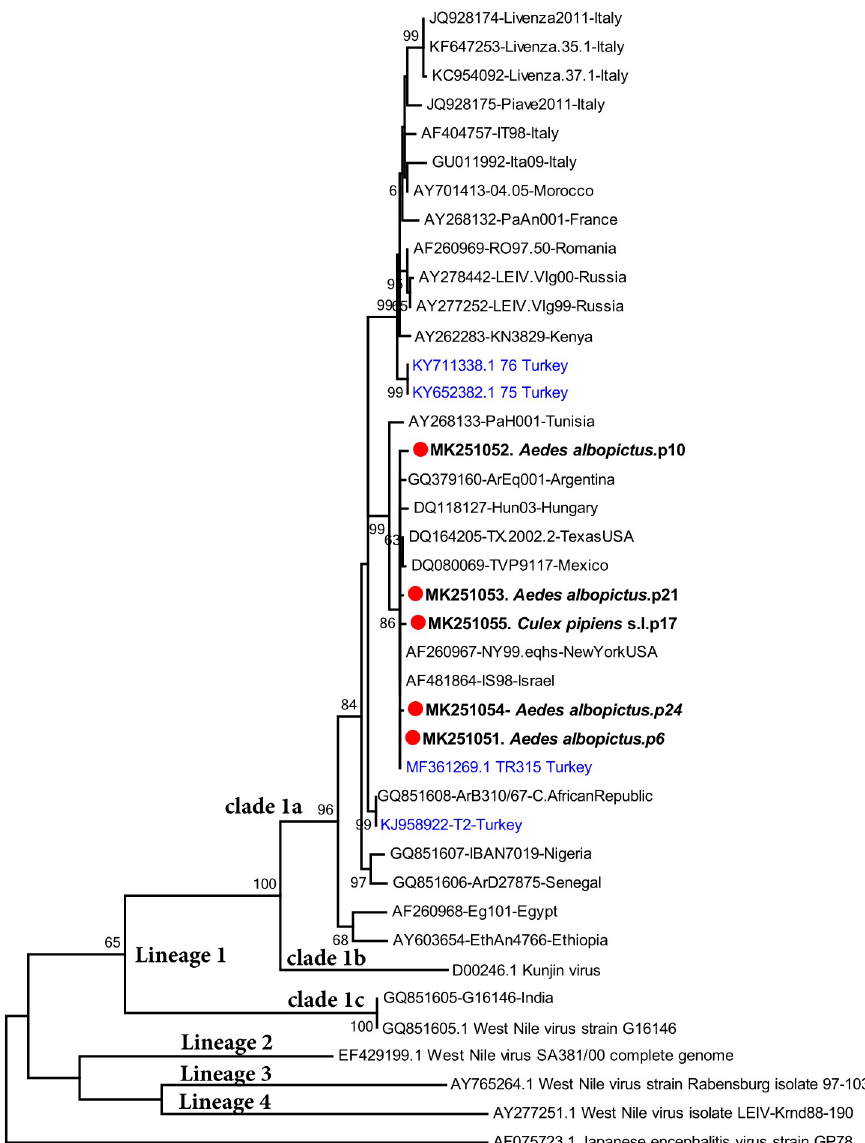
Fig 2. The maximum likelihood analysis of the partial West Nile virus NS5 sequences (777 nt). The tree is constructed using Maximum Likelihood method with the General Time Reversible (GTR) model, Gamma distributed with Invariant sites (G+I) for 1000 replications. The sequences characterized in this study are given in bold and indicated with a symbol, GenBank accession number, hosting mosquito species and pool code. Global virus strains are indicated by GenBank accession number, strain/isolate name and country of detection. Viruses previously characterized in Turkey are indicated with blue letters. Bootstrap values higher than 60 are provided. Japanese encephalitis virus strain GP78 is included as an